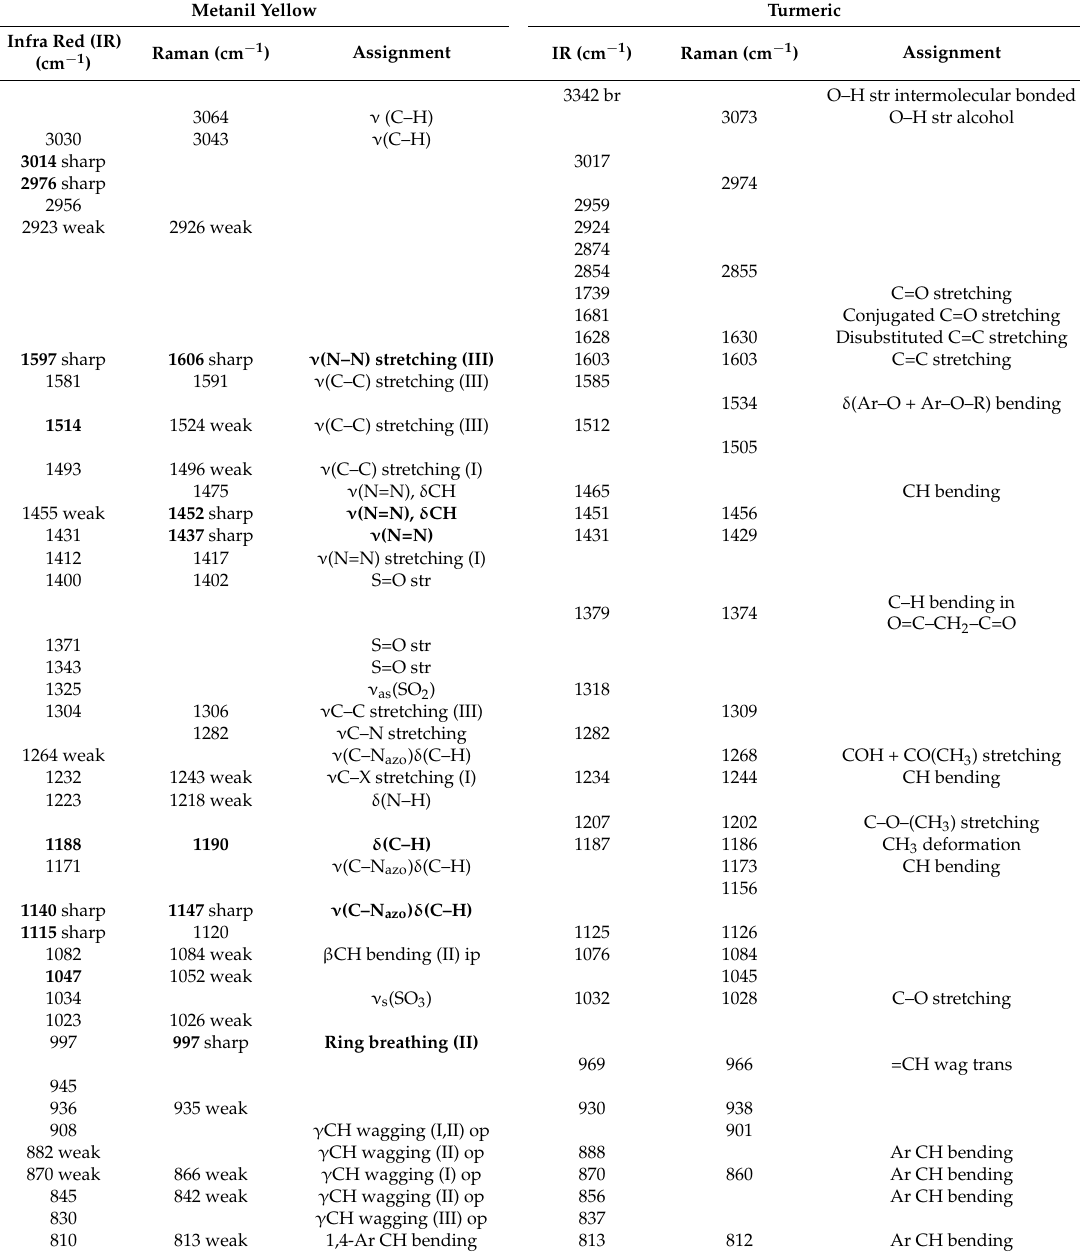
Table 1. Assignment of FT-Raman and FT-IR spectral bands